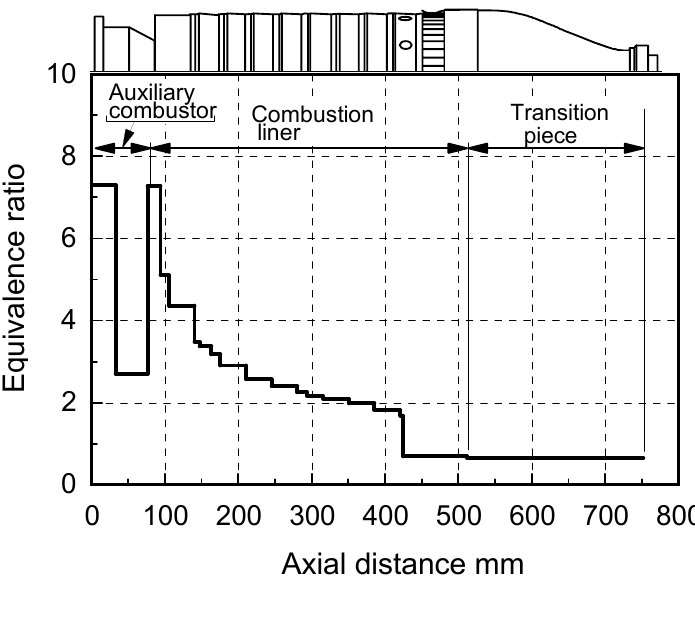
Figure 76. Axial distribution of equivalence ratio at the rated load